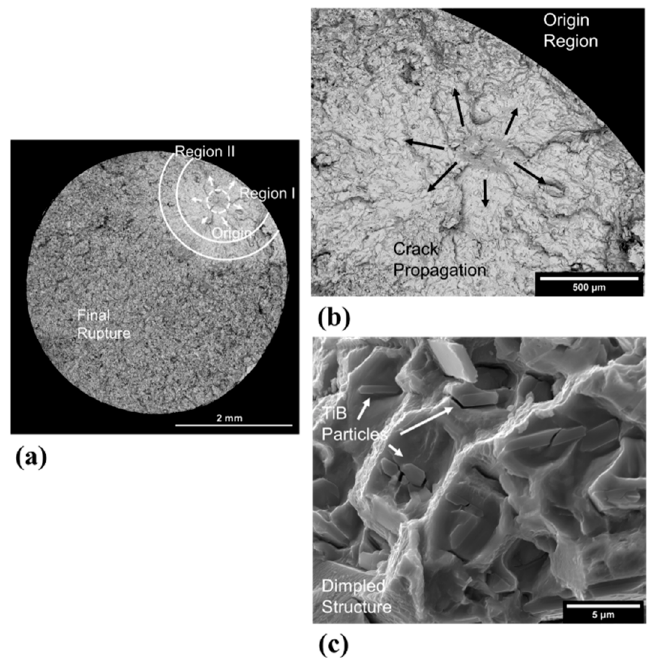
Figure 16. ( a ) BSE ‐ SEM image highlighting the overall fracture surface of a shot ‐ peened PTA ‐ SFFF Ti–TiB fatigue sample, which was tested at a stress amplitude of 507.5 MPa and failed at 48,000 cycles. ( b ) BSE ‐ SEM image highlighting the fatigue crack origin area, taken from the enclosed area in Region I highlighted in ( a ). ( c ) SE ‐ SEM image showing a dimpled structure with TiB particles within dimples, taken from the enclosed area in the Final Rupture region highlighted in ( a ).